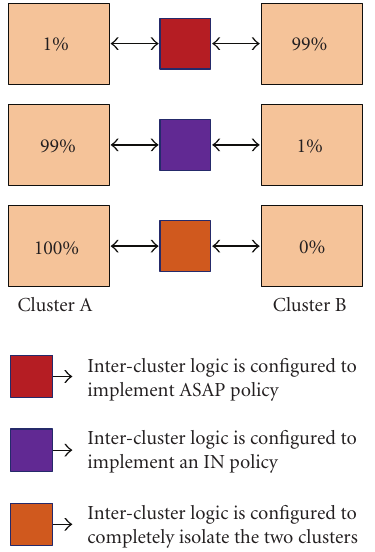
Figure 8: Example Scenarios for Using the Two Policies for Com- munication between Clusters and Isolation Property of